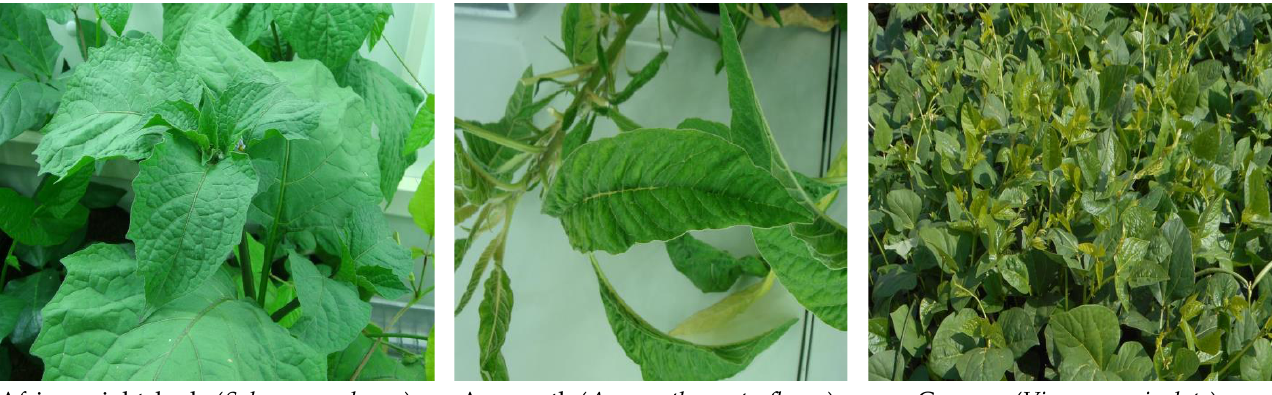
Figure 9. The African indigenous leafy vegetables nightshade ( Solanum scarbrum ), cowpea ( Vigna unguiculata), and amaranth ( Amaranthus retroflexus ).